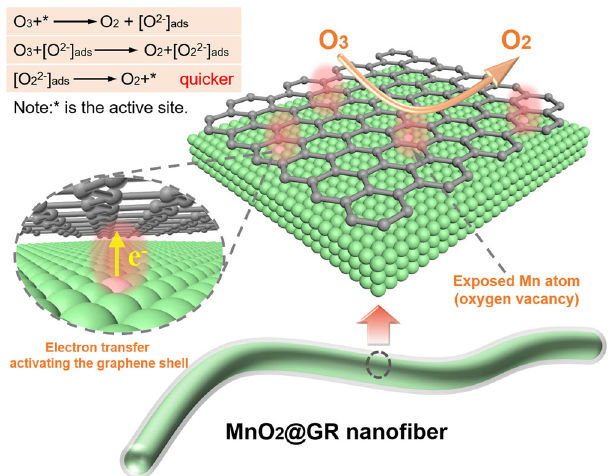
Fig. 7 The schematic illustration of ozone-catalytic decomposition on MnO 2 @GR. In this scheme, the possible reaction processes of ozone- catalytic decomposition on the graphite carbon near unsaturated Mn atoms are proposed. The electron transfer from the unsaturated Mn atoms to the graphene shell turns the graphite carbon close to the unsaturated Mn atoms to be active Fig. S27), we propose that the graphitic carbon close to Mn atoms MnO 2 @GR. The local work function of the carbon sites around oxygen vacancy is lower than that of the graphene layer and